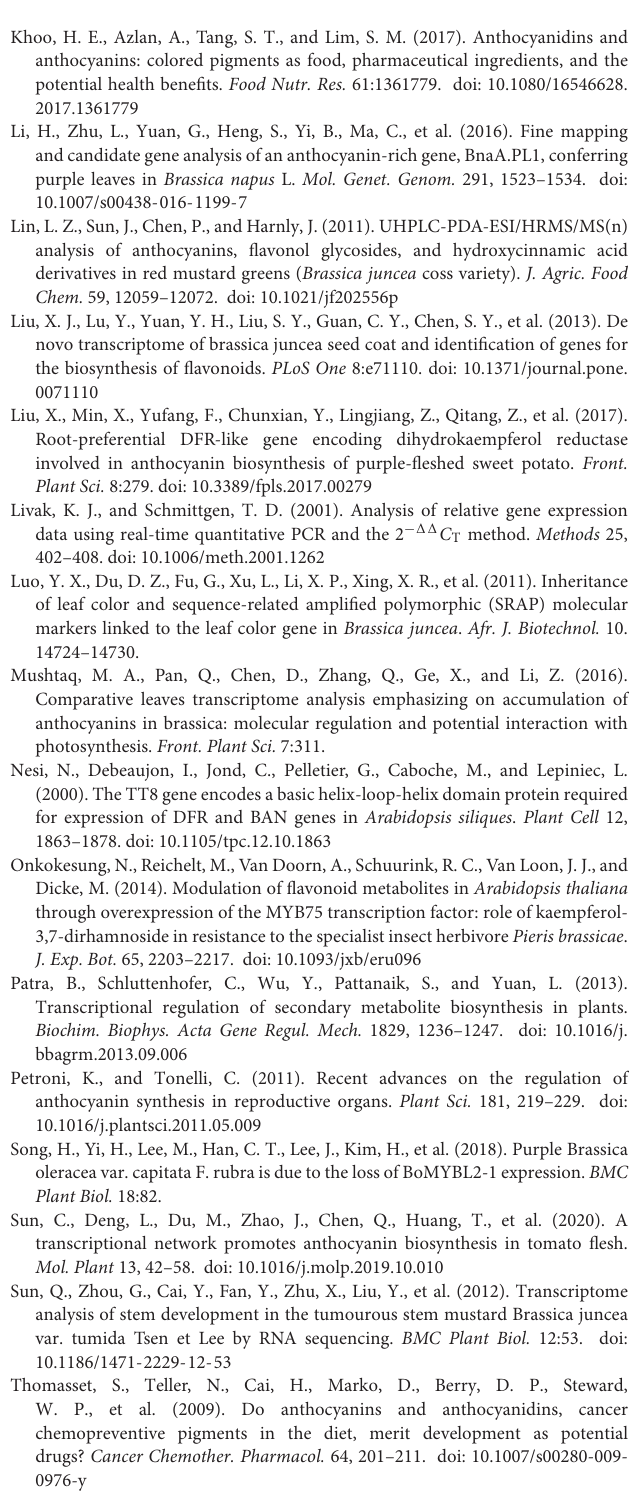
TABLE S4 | Differentially expressed transcription factors between the purple leaves and green leaves. TABLE S5 | Orthologous genes involved in anthocyanin biosynthesis in B. juncea